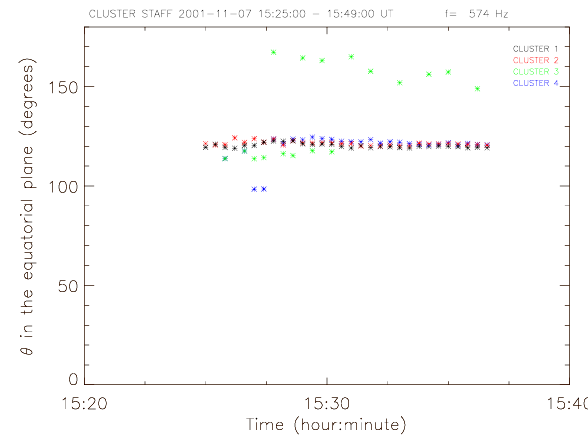
Fig. 9. Same as Fig. 4 but for 7 November 2001 between 15:25 and